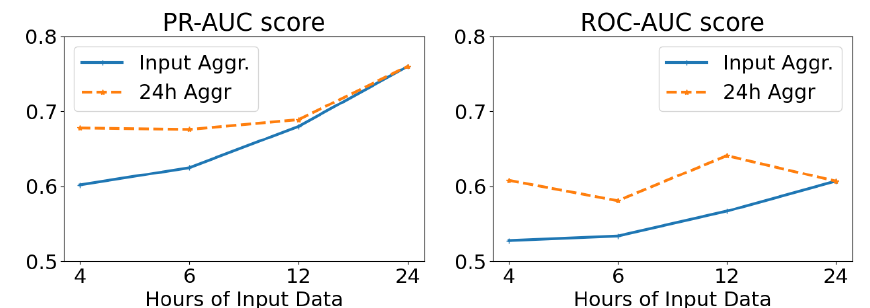
Figure 12. Ablation study on the effect of the length (duration covered in hours) of the input tensors and the aggregation period, for the CNN AE